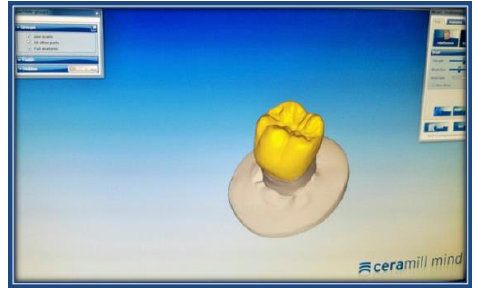
Figure 4: Final crown design before milling CEREC in Lab MCXL